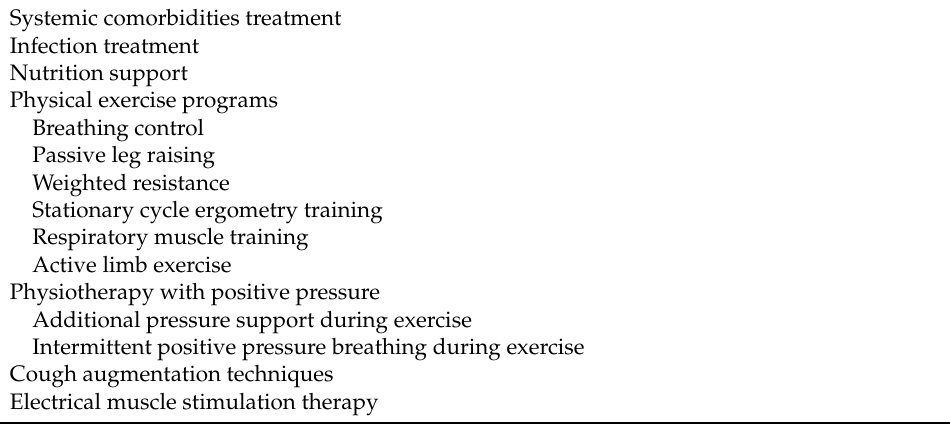
Table 2. Management of prolonged mechanical